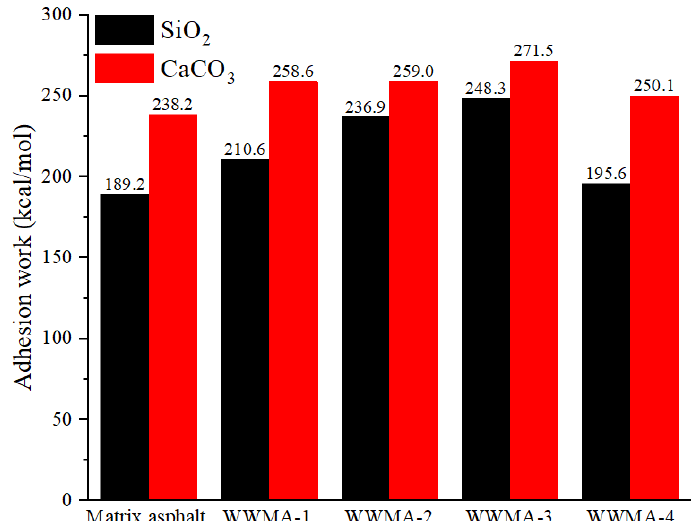
Figure 10. The adhesion work of each asphalt with SiO 2 and CaCO 3 .